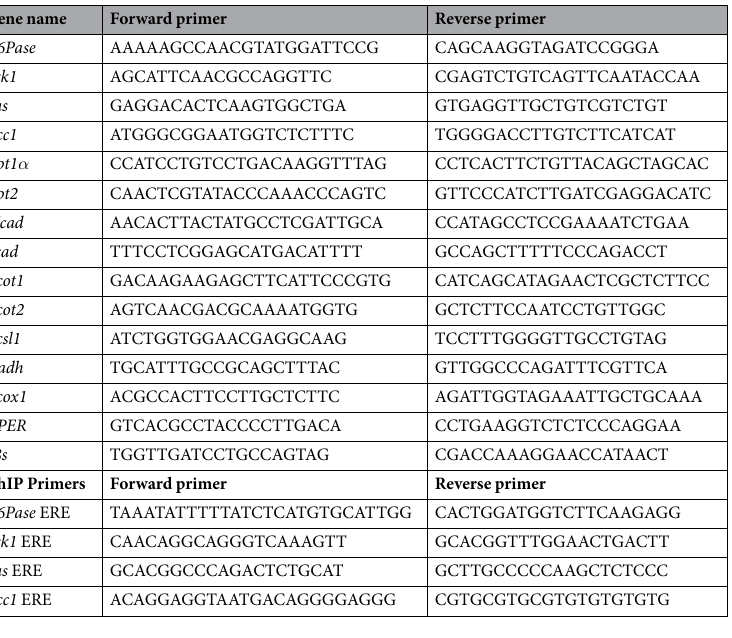
Table 1. Sequences of